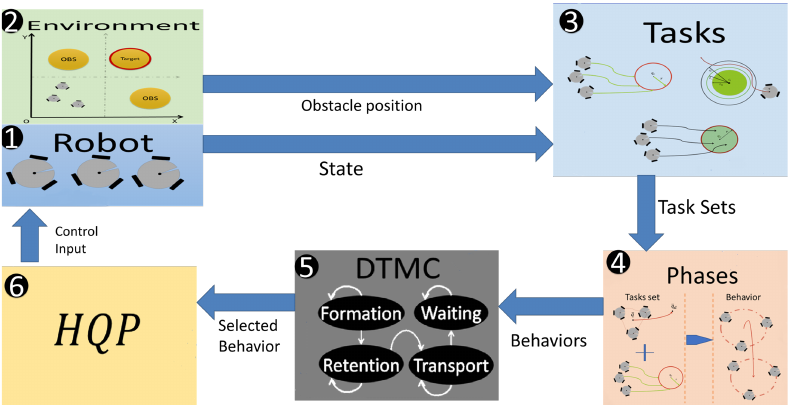
Figure 1. The Manipulation scheme involves six interconnected blocks: 1. Robots, representing the omnidirectional robots; 2. Environment, the operational space for the robots; 3. Tasks, the specific goals to be achieved by the robots; 4. Phases, the stages involved in the manipulation scheme; 5. DTMC, which utilizes a discrete-time Markov chain; and 6. HQP, which computes the control of the robots to carry out simultaneous